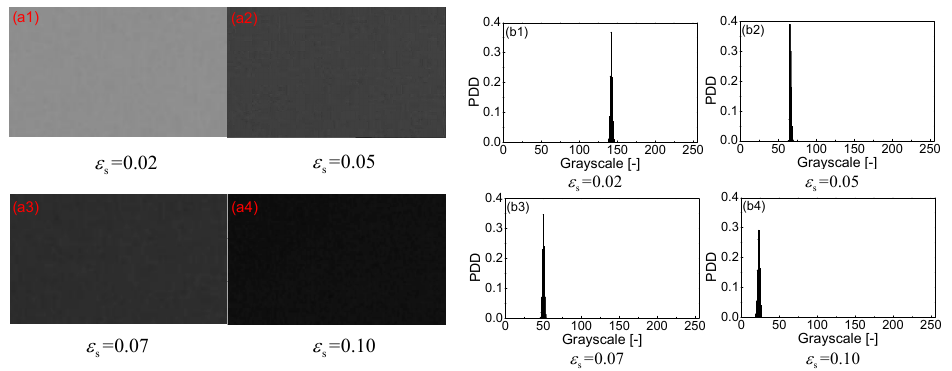
Figure 6. Particle image under different solids holdups for Group A sand particles.